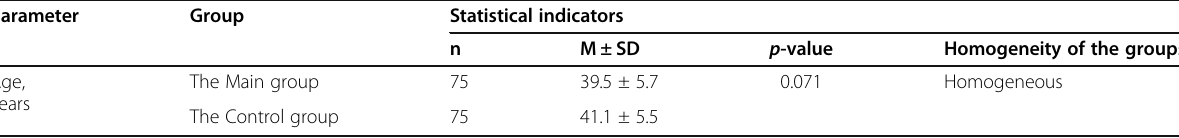
Table 2 Allocation of patients according to age